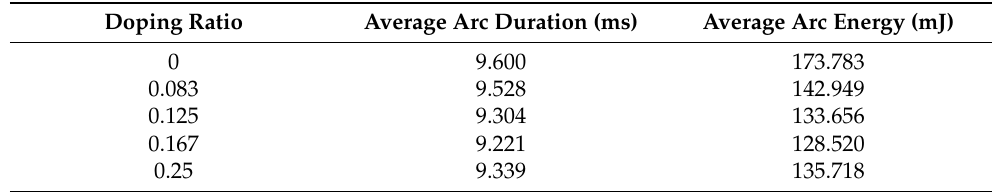
Table 7. Arc duration and arc